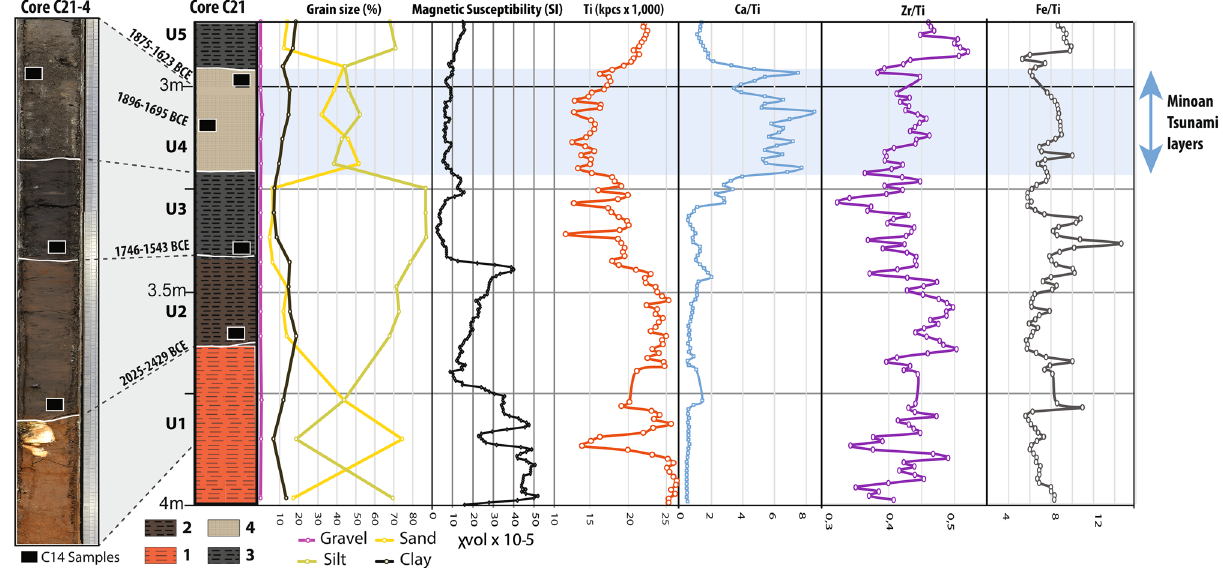
Figure 4. Detail of the C21 core (C21-4 and C21-3 section) with radiocarbon sampling locations (black boxes), grain size, magnetic susceptibility and selection of major elements and geochemical ratios of clastic